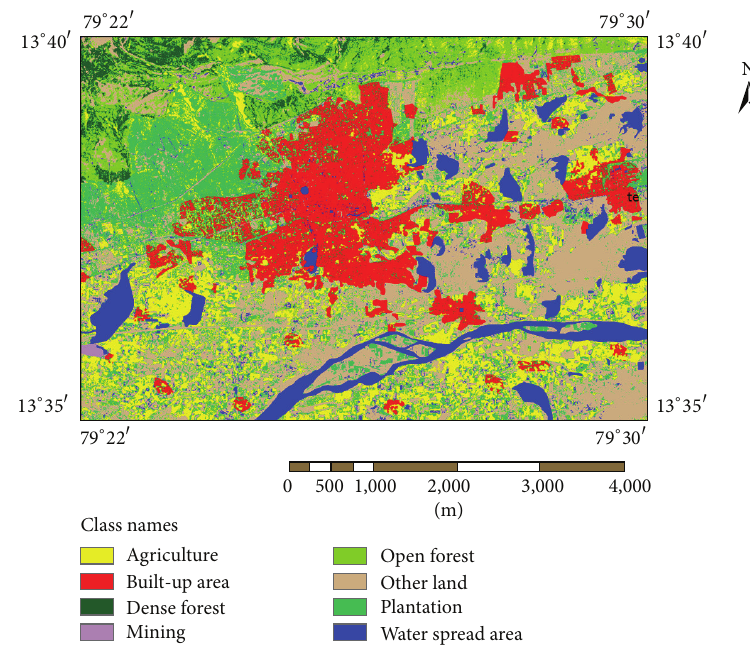
Figure 4: Land use/land cover in 2003.